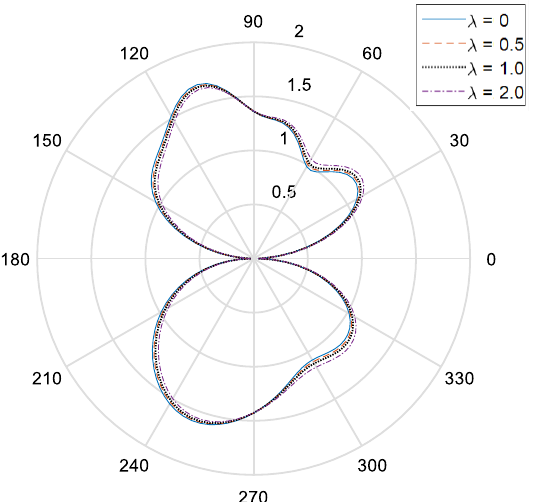
Figure 6. Dynamic stress concentration factor around the upper opening in piezomagnetic compo- sites ( ka  2.0,